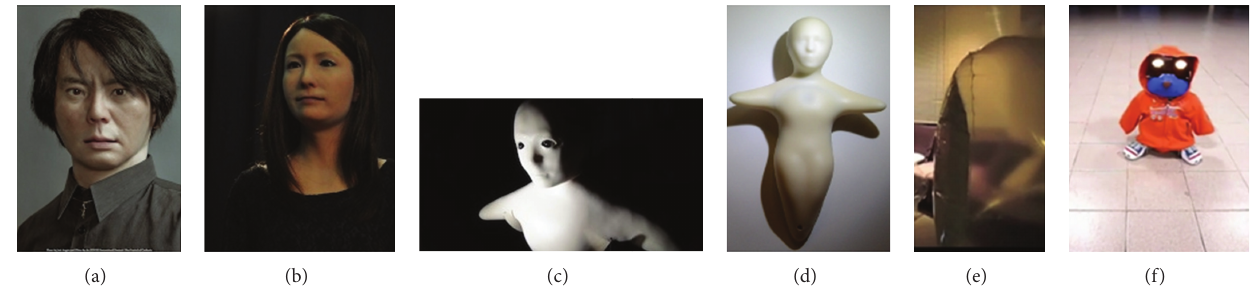
Figure 2: (a) Geminoid HI-2, (b) Geminoid F, (c) Telenoid, (d) Elfoid, (e) Floating avatar, and (f) TRiC mini